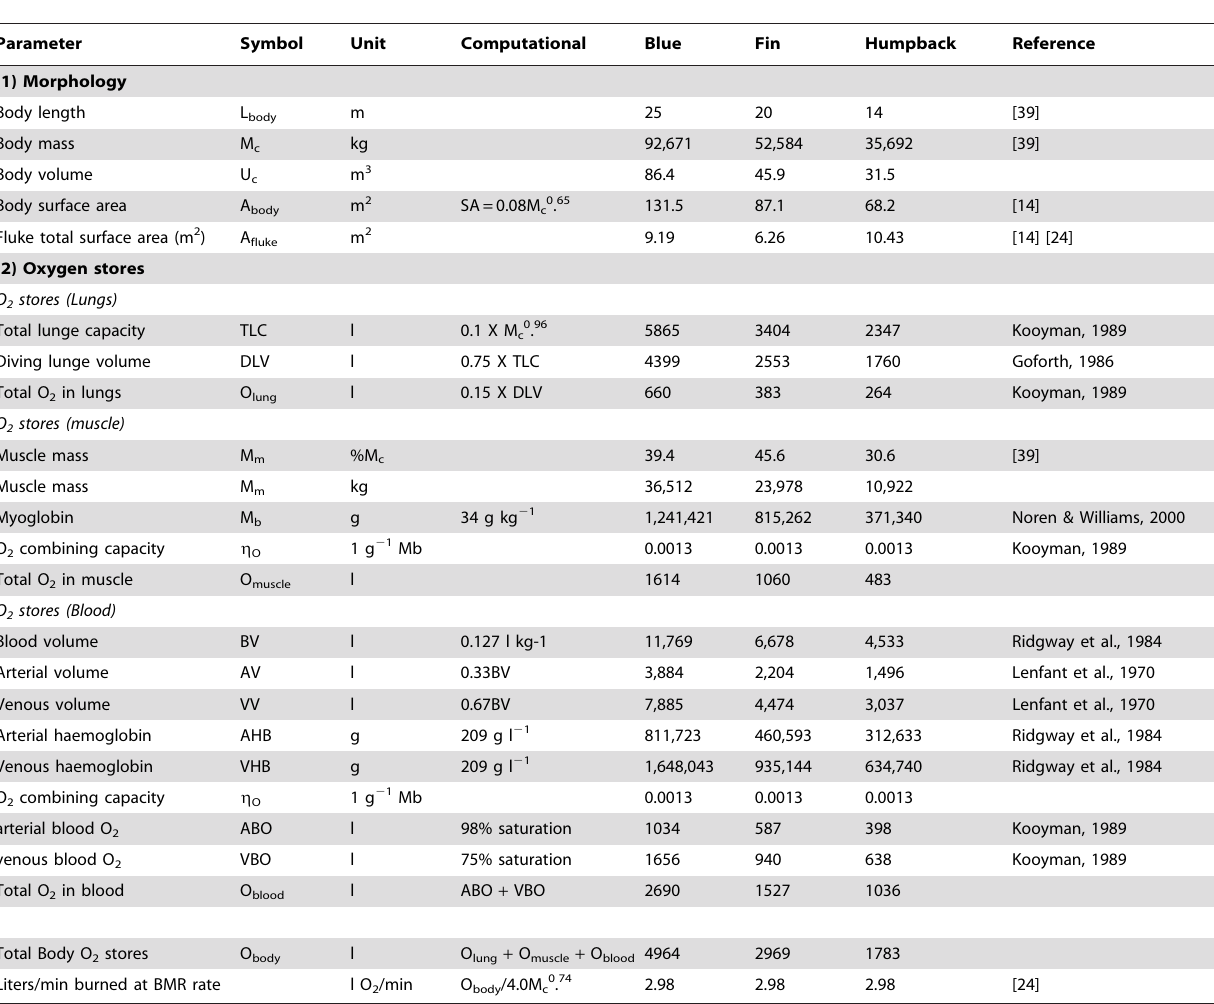
Table 9. Values used in the calculation of the Filter/Recovery Metabolic rate (F/RMR; equation 5).